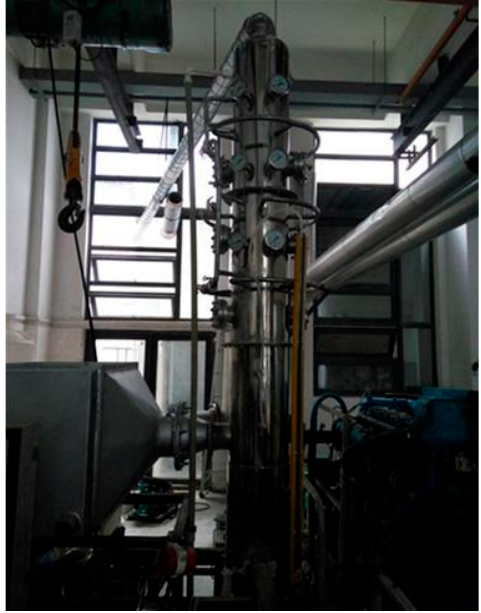
Figure 2. The 6135-type spray tower.